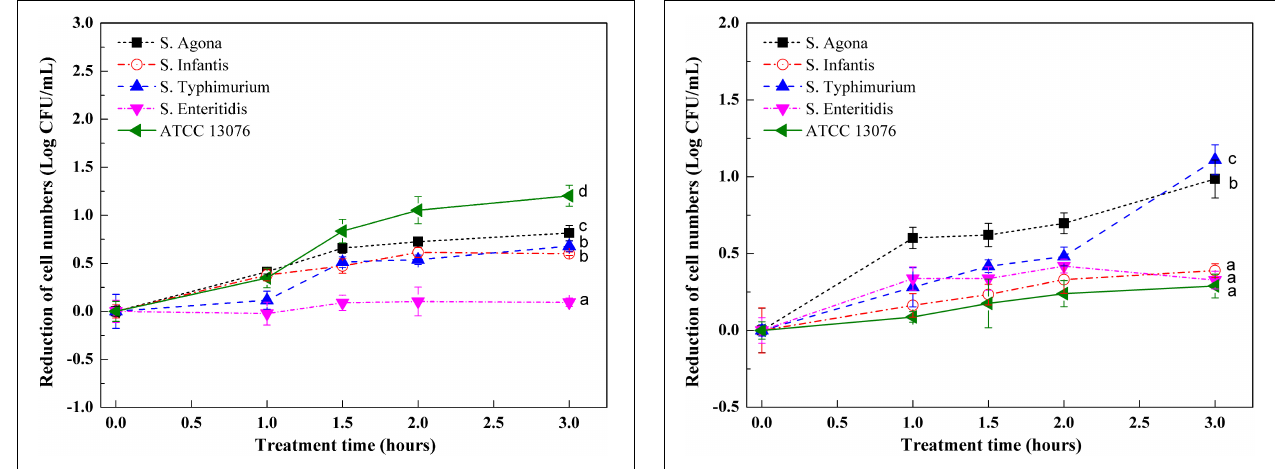
FIGURE 3 | The variation of cell numbers of five Salmonella strains when exposed to oxidative stress. Each symbol indicates the mean ± standard deviation of five independent experiments ( n = 5). Different lowercase letters at treatment of 3 h indicated significant difference ( p < 0.05).